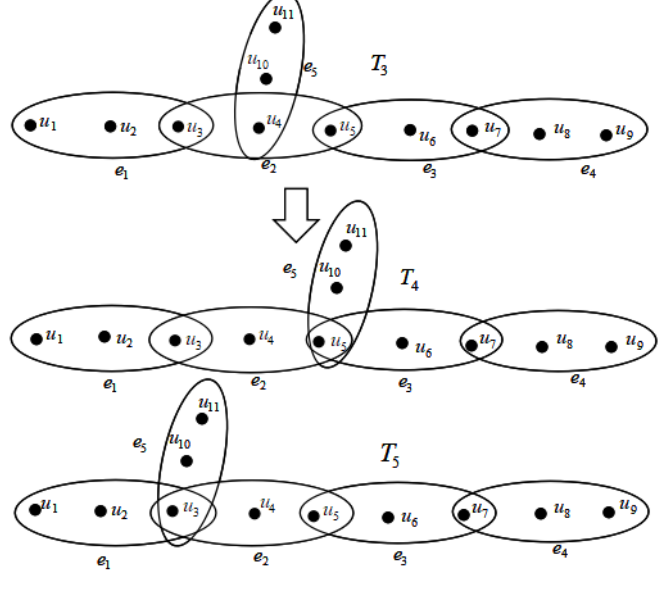
Figure 3. Transformation I on T 3 .